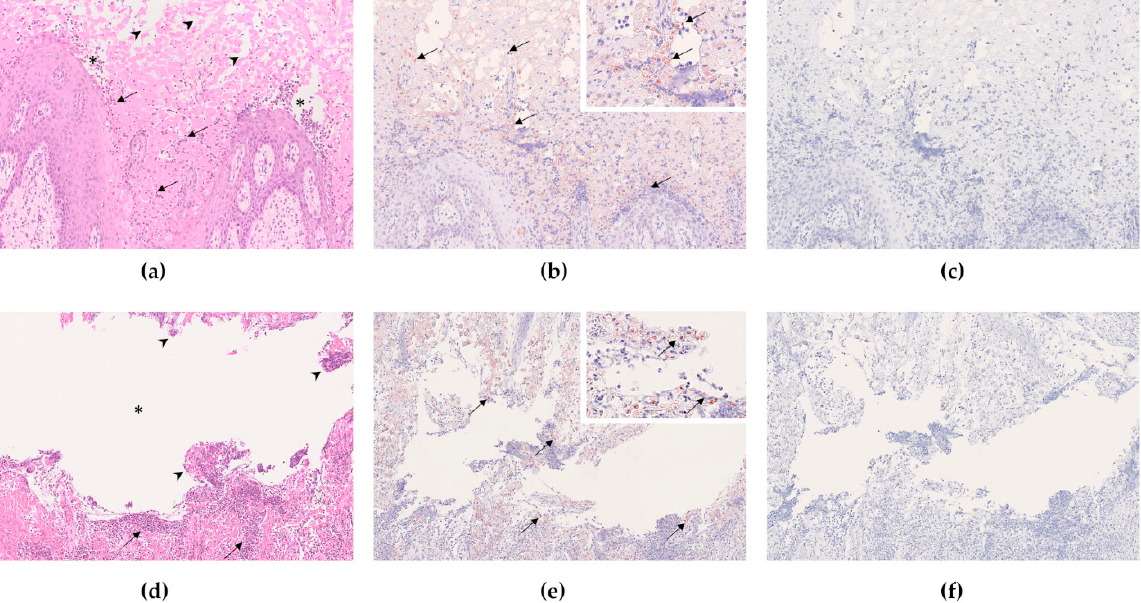
Figure 5. Pathohistological findings after injection of naked FMDV RNA into the tongue in the first an- imal trial (( a – c ), tongue, 5 × magnification; d–f, interdigital space, 10 × magnification). ( a ) Animal 249, tongue, H.E. staining. The lingual mucosa shows characteristic vesiculopustular lesions containing neutrophils and sloughed epithelial cells (asterisk). The adjacent mucosa is infiltrated by neutrophils (arrows) and reveals clear intercellular spaces between swollen and degenerating keratinocytes (ar- rowheads). ( b ) Animal 249, tongue, anti-FMDV immunohistochemistry. Associated with the lesions as described in a), FMDV-antigen-positive cells (red–brown signal, arrows) were detected throughout the lingual mucosal epithelium. The inset shows positively stained cells at higher magnification. ( c ) Animal 249, tongue, pre-immune serum immunohistochemistry (negative control). To confirm the specificity of the anti-FMDV antibody staining, tissue sections were incubated with pre-immune serum. Unspecific binding was excluded as no positively labeled cells were detected. ( d ) Animal 260, interdigital space, H.E. staining. Overview of a large vesicle in the interdigital cleft. A large intraepidermal space (asterisk) is filled with neutrophils and degenerate keratinocytes (arrowheads). The adjacent epidermis is severely infiltrated by neutrophils (arrows) intermingled with degenerating keratinocytes. ( e ) Animal 260, interdigital space, anti-FMDV immunohistochemistry. Numerous cells within the lesion were FMDV-antigen positive (arrow). The inset shows positively stained cells at higher magnification. ( f ) Animal 260, interdigital space, pre-immune serum immunohistochemistry. As described for ( c ), unspecific binding of the FMDV antibodies was ruled out as no positive signal was detectable with the pre-immune